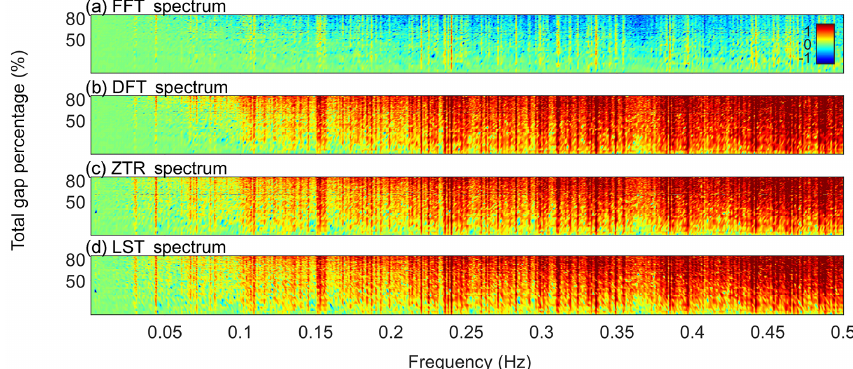
Figure 17. MSG test applied to the VEX data set. The format is similar to Fig. 14.